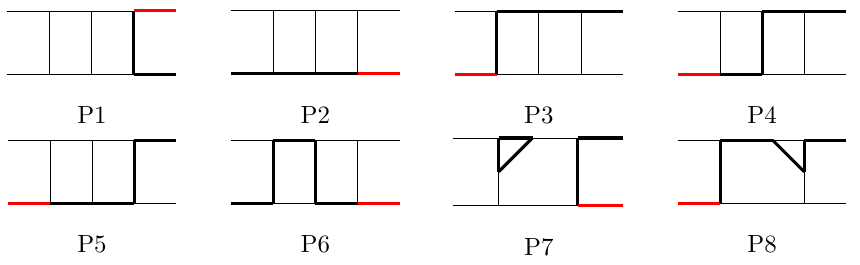
Figure 1. Planar integral topologies in the top sectors for gb → tW . The thick black and red lines represent the top quark and the W boson, respectively. The other lines denote massless particles.